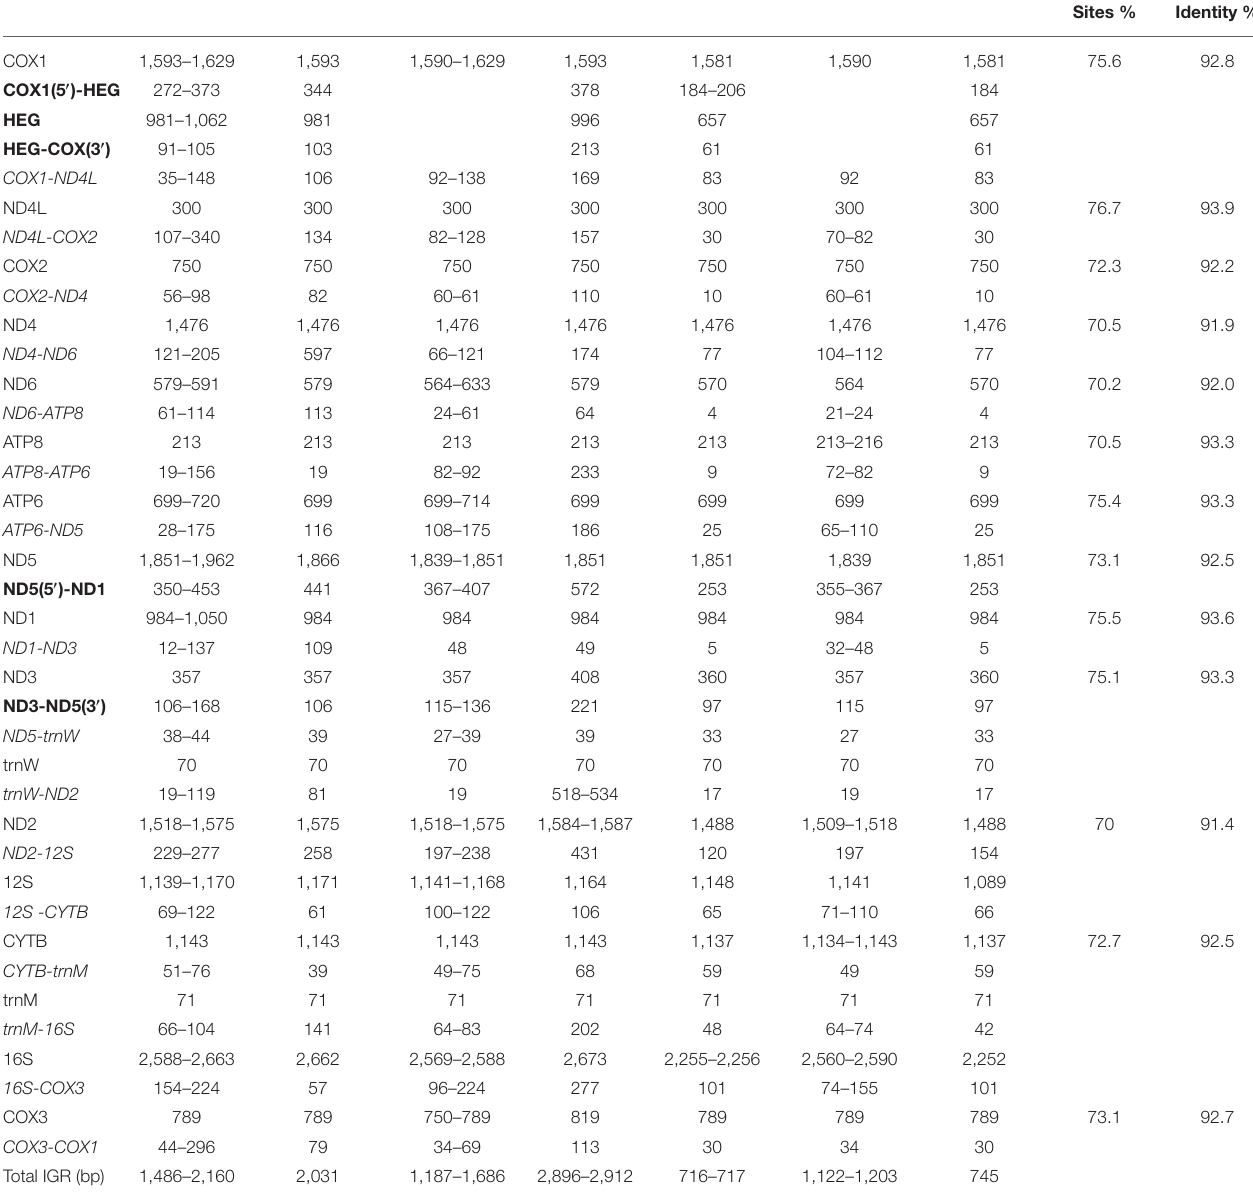
TABLE 2 | Antipatharian family gene lengths (bp), intergenic regions (italicized) (bp), intron regions (bold) (bp) and gene variation from Gblock alignments (percentage identical sites and percentage pairwise identity). Antipathidae Aphanipathidae Cladopathidae Leiopathidae Myriopathidae Schizopathidae Stylopathidae Identical